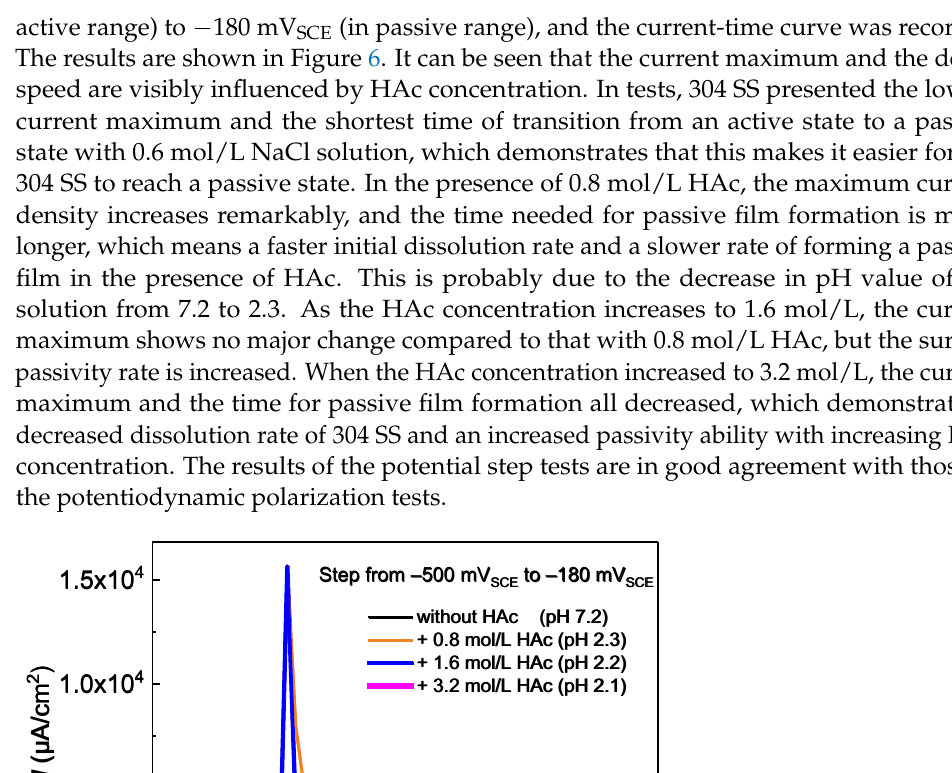
8 of 17 Figure 5. Typical current fluctuation of 304 SS in 0.6 mol/L NaCl solution, using a potentiodynamic polarization test ( a ) and average growth rate of metastable pits on 304 SS, in 0.6 mol/L NaCl